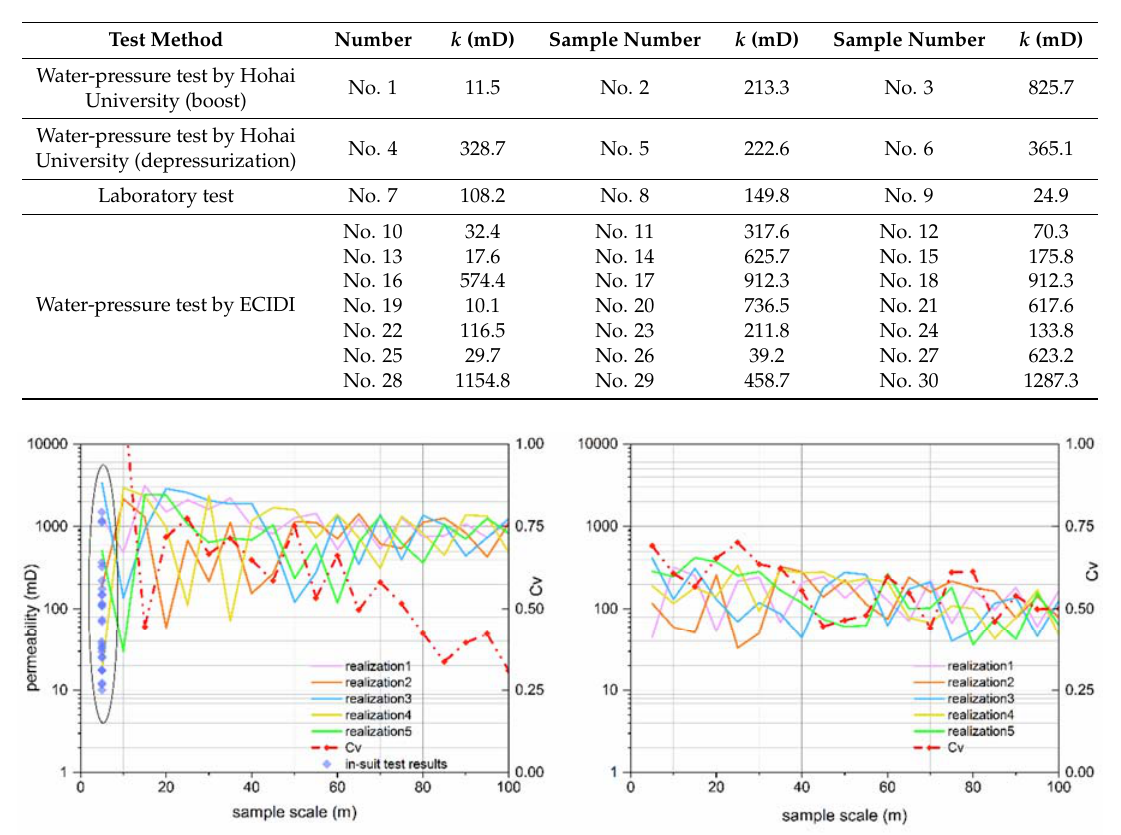
Figure 16. Comparison between the calculated permeability of C 3 and its field-test results (the ISWZ scale is about 4 m): horizontal permeability ( left ) and vertical permeability ( right ).